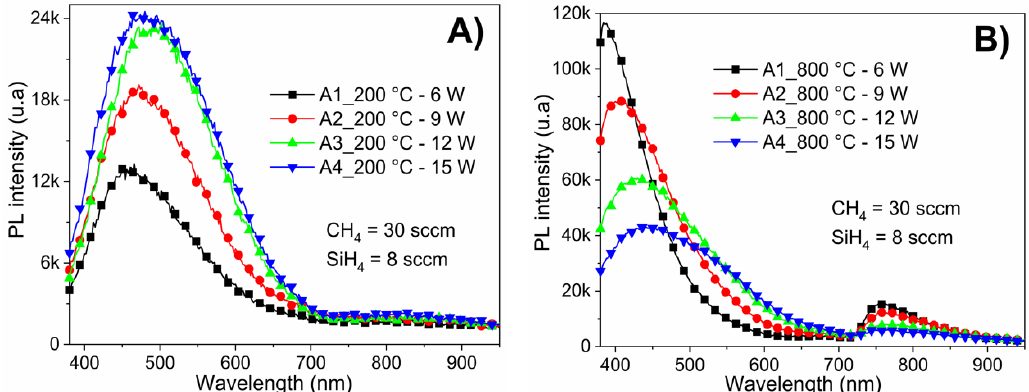
Figure 6. PL spectra of a-Si 1 – x C x :H films deposited with different RF power (6 – 15 W) while keeping the CH 4 /SiH 4 ratio (R 0 = 37.5) constant: ( A ) films annealed at 200 °C; and ( B ) films annealed at 800 °C.